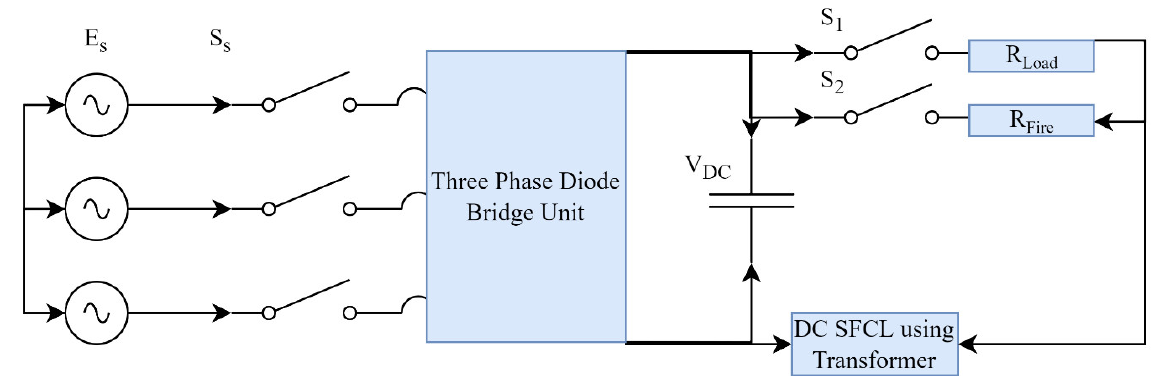
Figure 7. DC experimental circuit with a DC SFCL using a transformer.